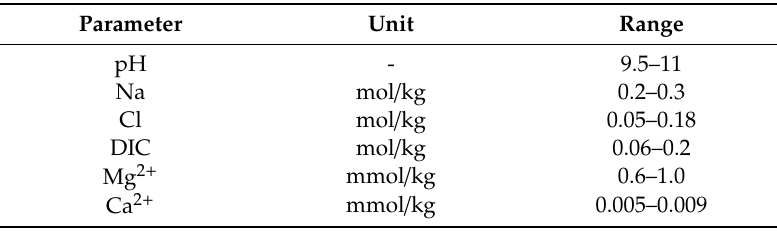
Table 3. Estimated pH and Na, Cl, total dissolved carbonate (as DIC), Mg 2 + , and Ca 2 + concentrations in Enceladus’